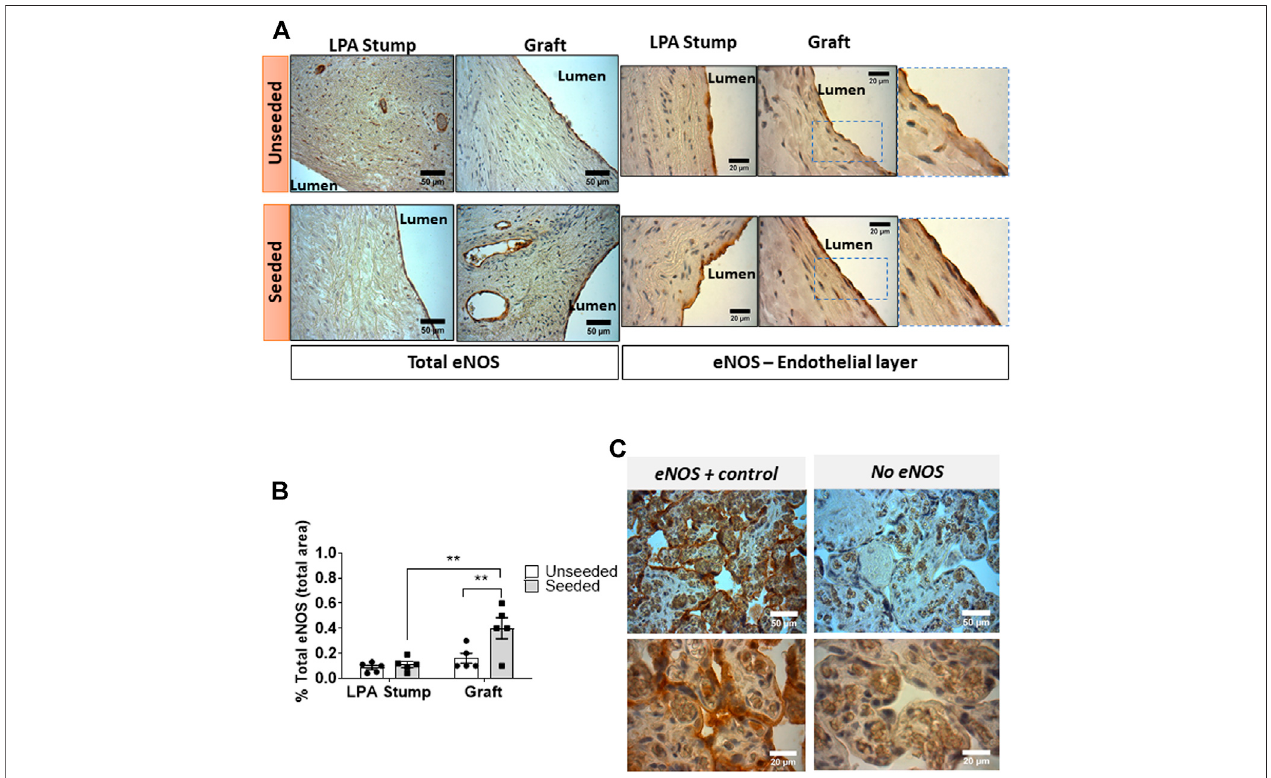
FIGURE 5 | Expression of eNOS expression in the implanted artery. (A) Light microscopy images displaying the expression of eNOS in the LPA stump and graft in the form ofbrownprecipitates. An intense staining, continuous stainingwasdetected inendothelialcells ofthe seeded grafts (both at the luminal sideand inintraparietal microvessels) compared with unseeded grafts. Moreover, weak positive staining could be appreciated in muscular cells underneath the luminal endothelial cells of the seeded grafts. (B) Bar graph showing the quanti fi cation of eNOS staining measured as the percentage of total section area. Images were quanti fi ed using a light microscope with 40x and 100x objectives. N (cid:1) 5 biological replicates per experimental group. Data are expressed as mean ± SEM. ** p < 0.01 (C) Cross-sections of human placental villi (used as a positive control) show the strong expression of eNOS in the